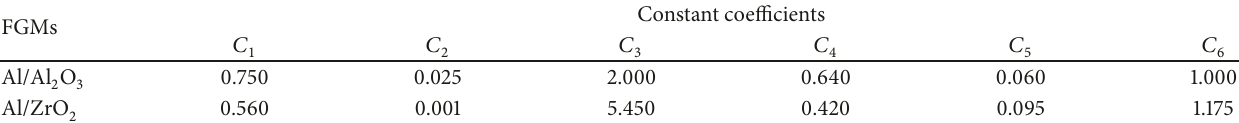
Table 3: The values of the constant coefficients used in 𝜅 function for two